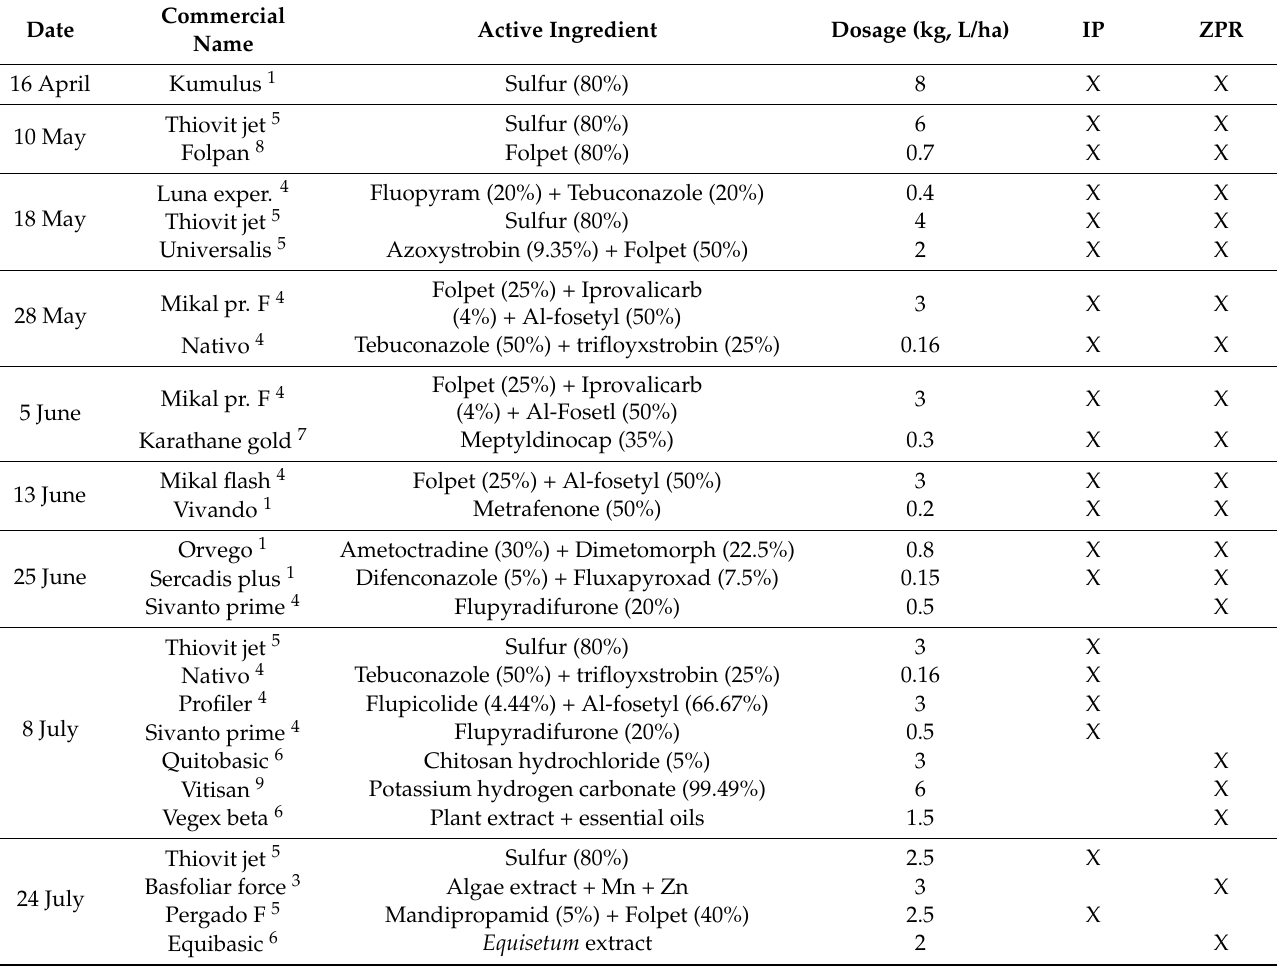
Table 2. Spray program for the Sauvignon vineyard in the 2021 season at integrated (IP) and 0- pesticide residue (ZPR) grape protection systems. Preparation was applied if marked with